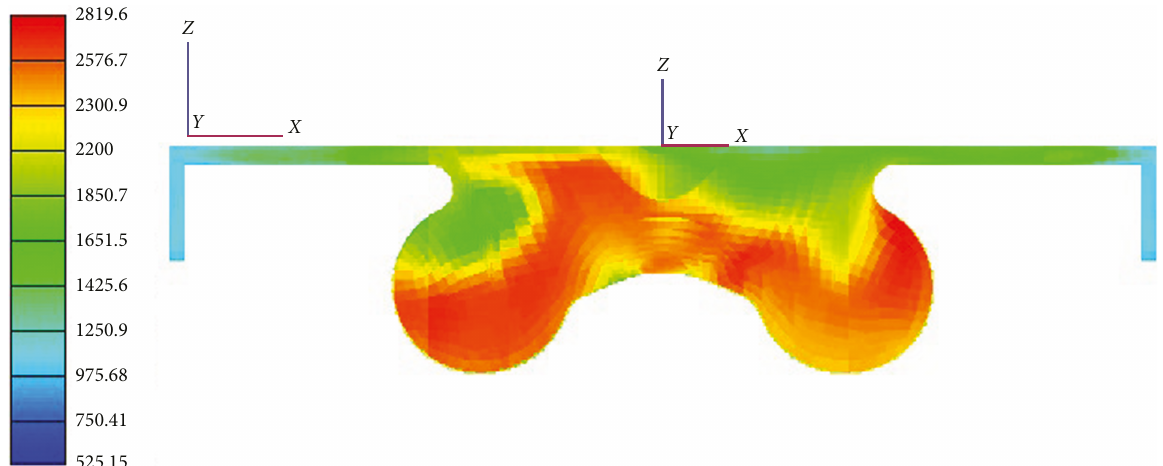
Figure 6: The temperature fi eld under 730 ° CA of program